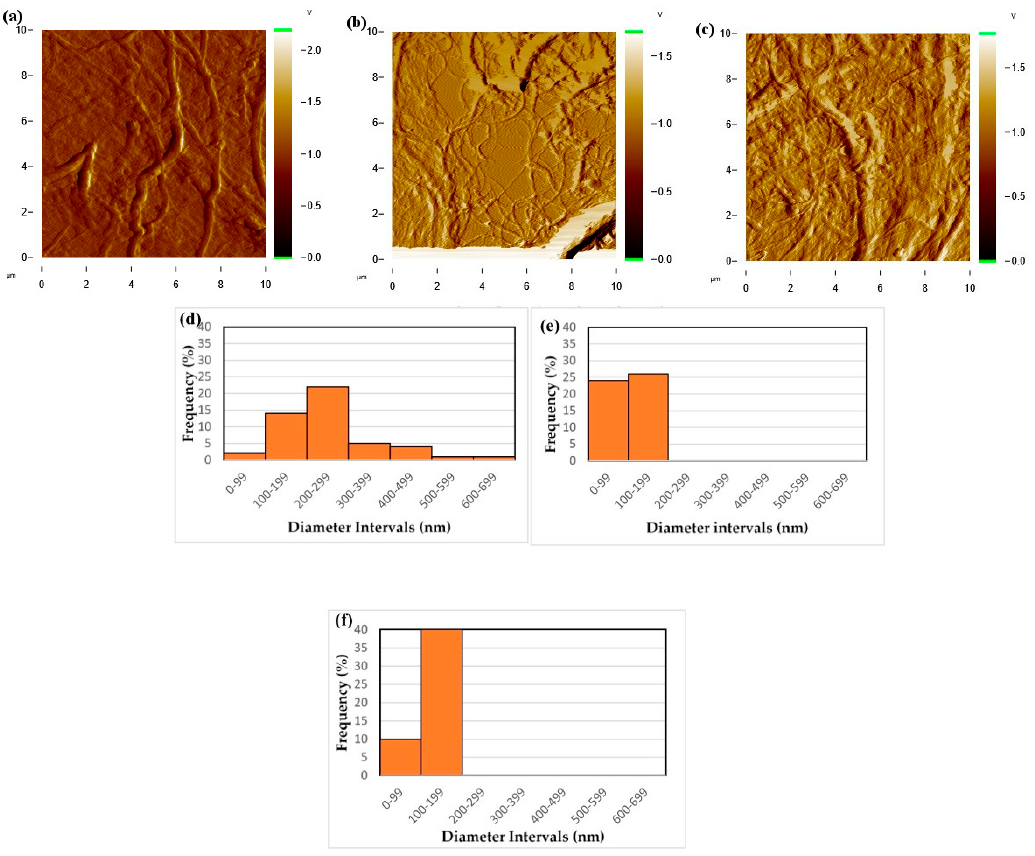
Figure 3. Atomic force microscopy (AFM) imagery of the CNF films: ( a ) CNF UG; ( b ) CNF 50G; ( c ) CNF 100G. Histogram of fibril size distributions for different CNF suspensions using AFM micrographs: ( d ) CNF UG; ( e ) CNF 50G; ( f ) CNF 100G.